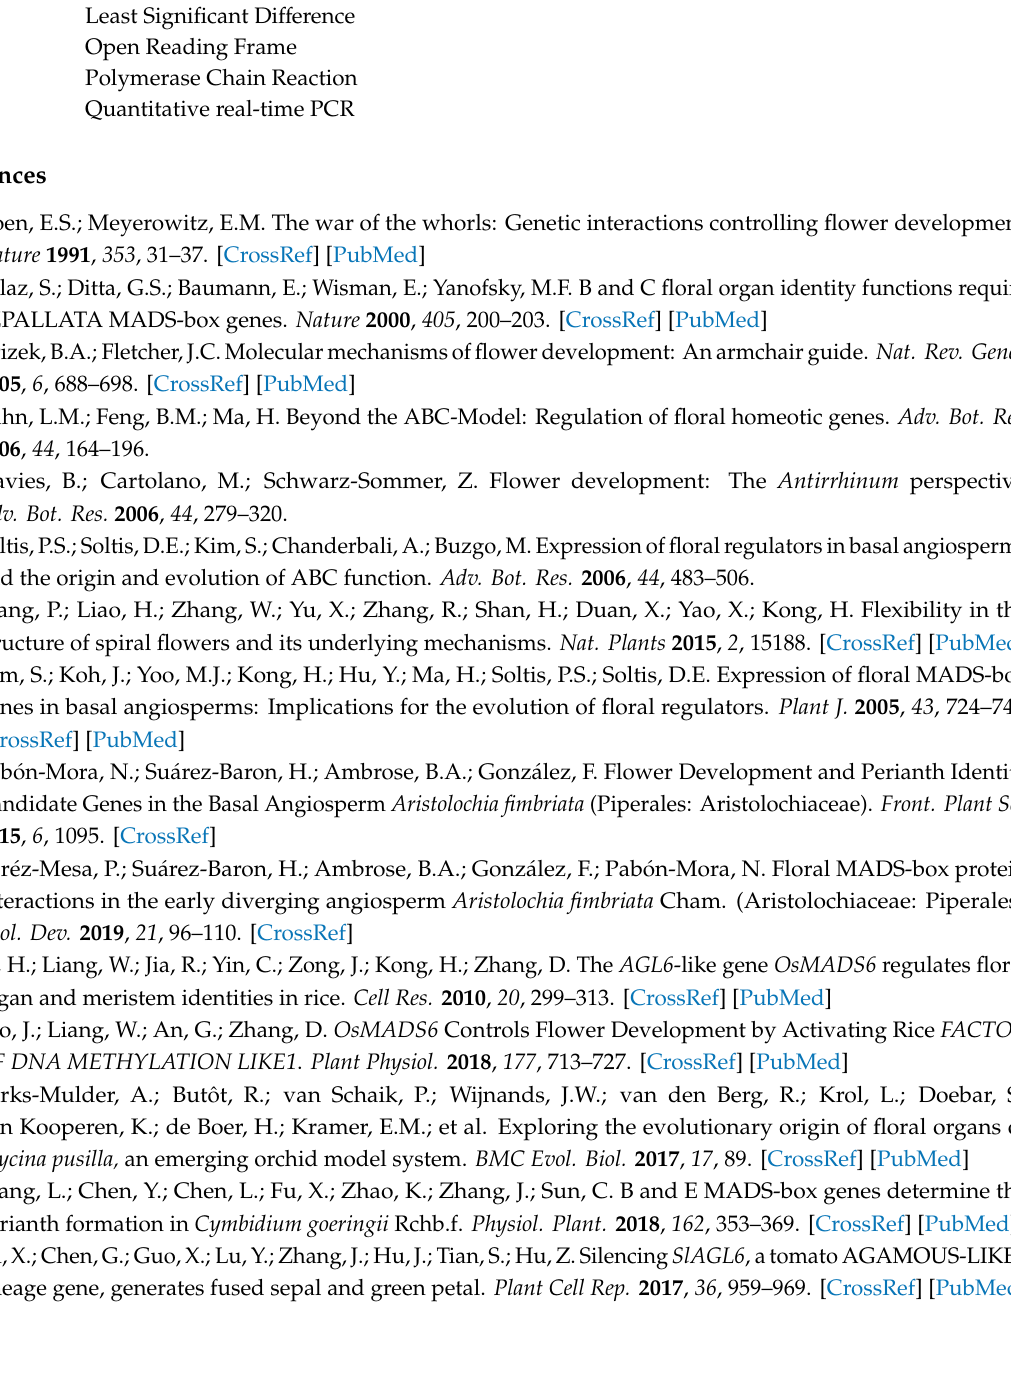
Table S1: Information on Sequences selected for alignments and phylogenetic analyses from NCBI